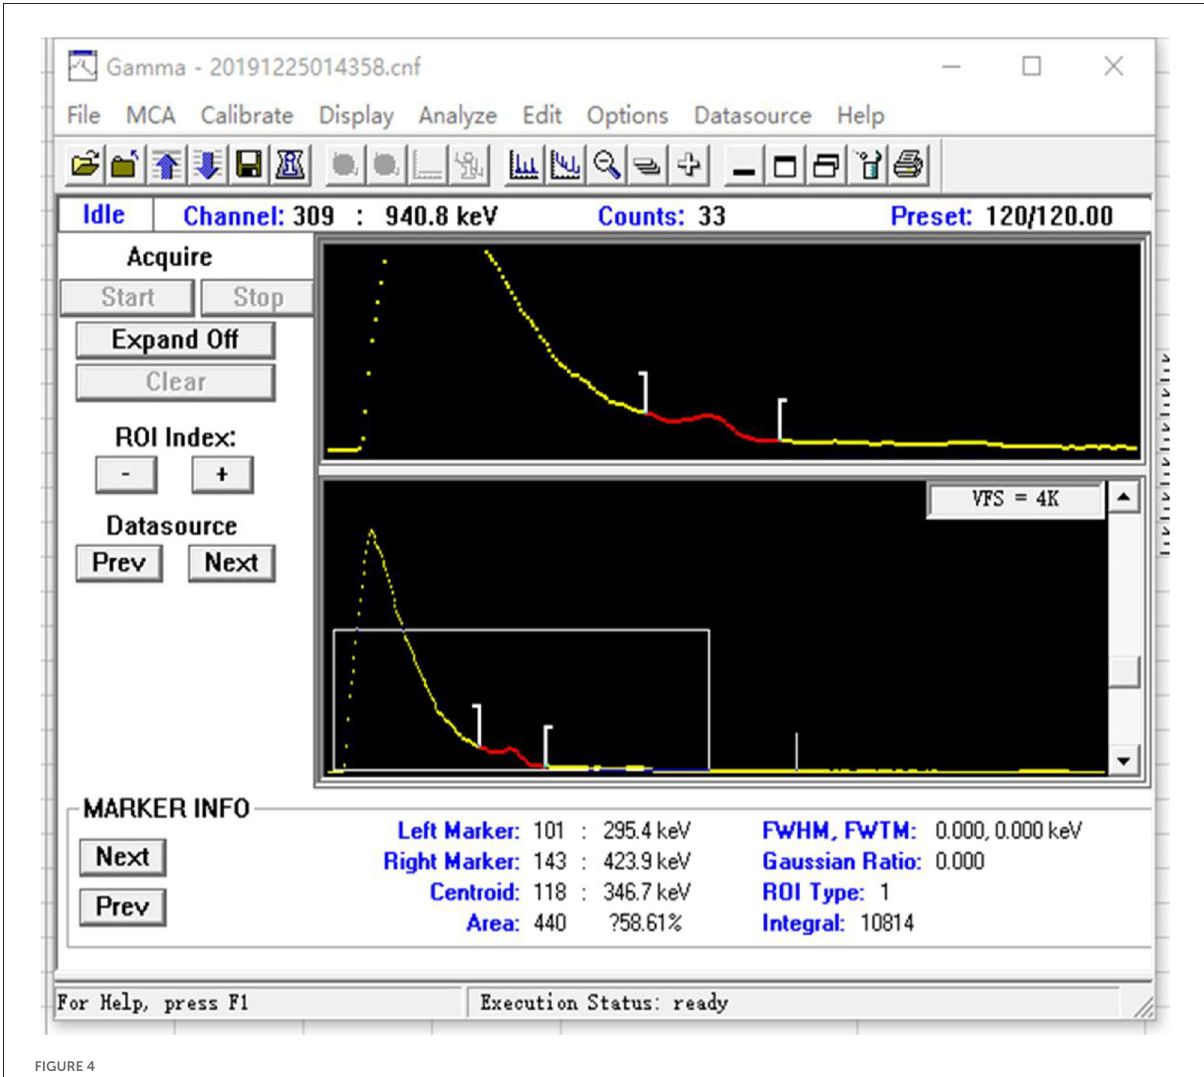
FIGURE4 (Background) Energy spectrum